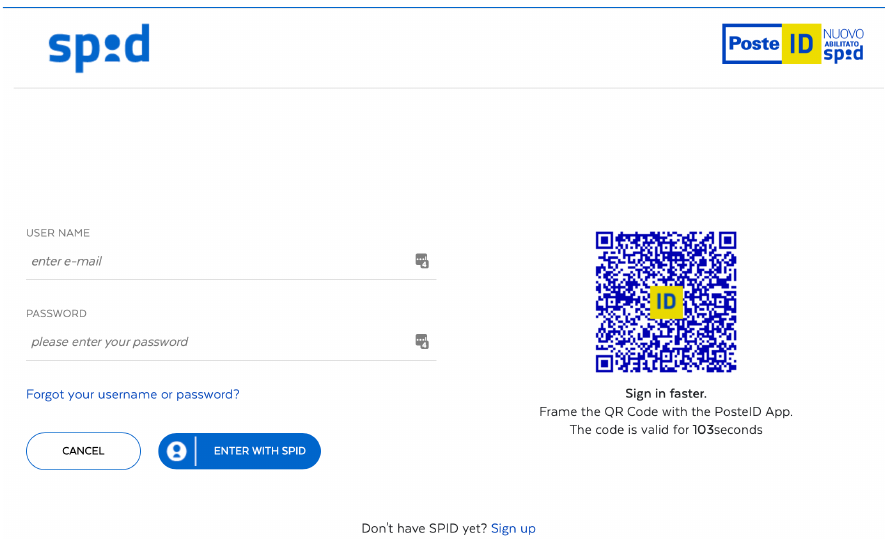
Figure 3. Login with password or login with QR